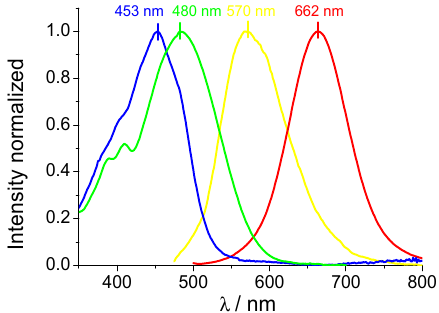
Figure 2. Normalized absorption spectra of the pure compounds DCM-HBU (blue line) and DCM − NH 2 (green line); normalized emission spectra of the pure compounds DCM-HBU (yellow line) and DCM-NH 2 (red line) by excitation at 453 nm and 480 nm, respectively. The addition of TYR (0.13 mg mL − 1 ) to the DCM-HBU in PBS/DMSO (7/3, v/v), 25 μ M, and pH = 7.4 solution resulted in a decrease in the emission band with λ max = 570 nm ( λ ex = 453 nm) corresponding to the probe, along with a concomitant increase in the